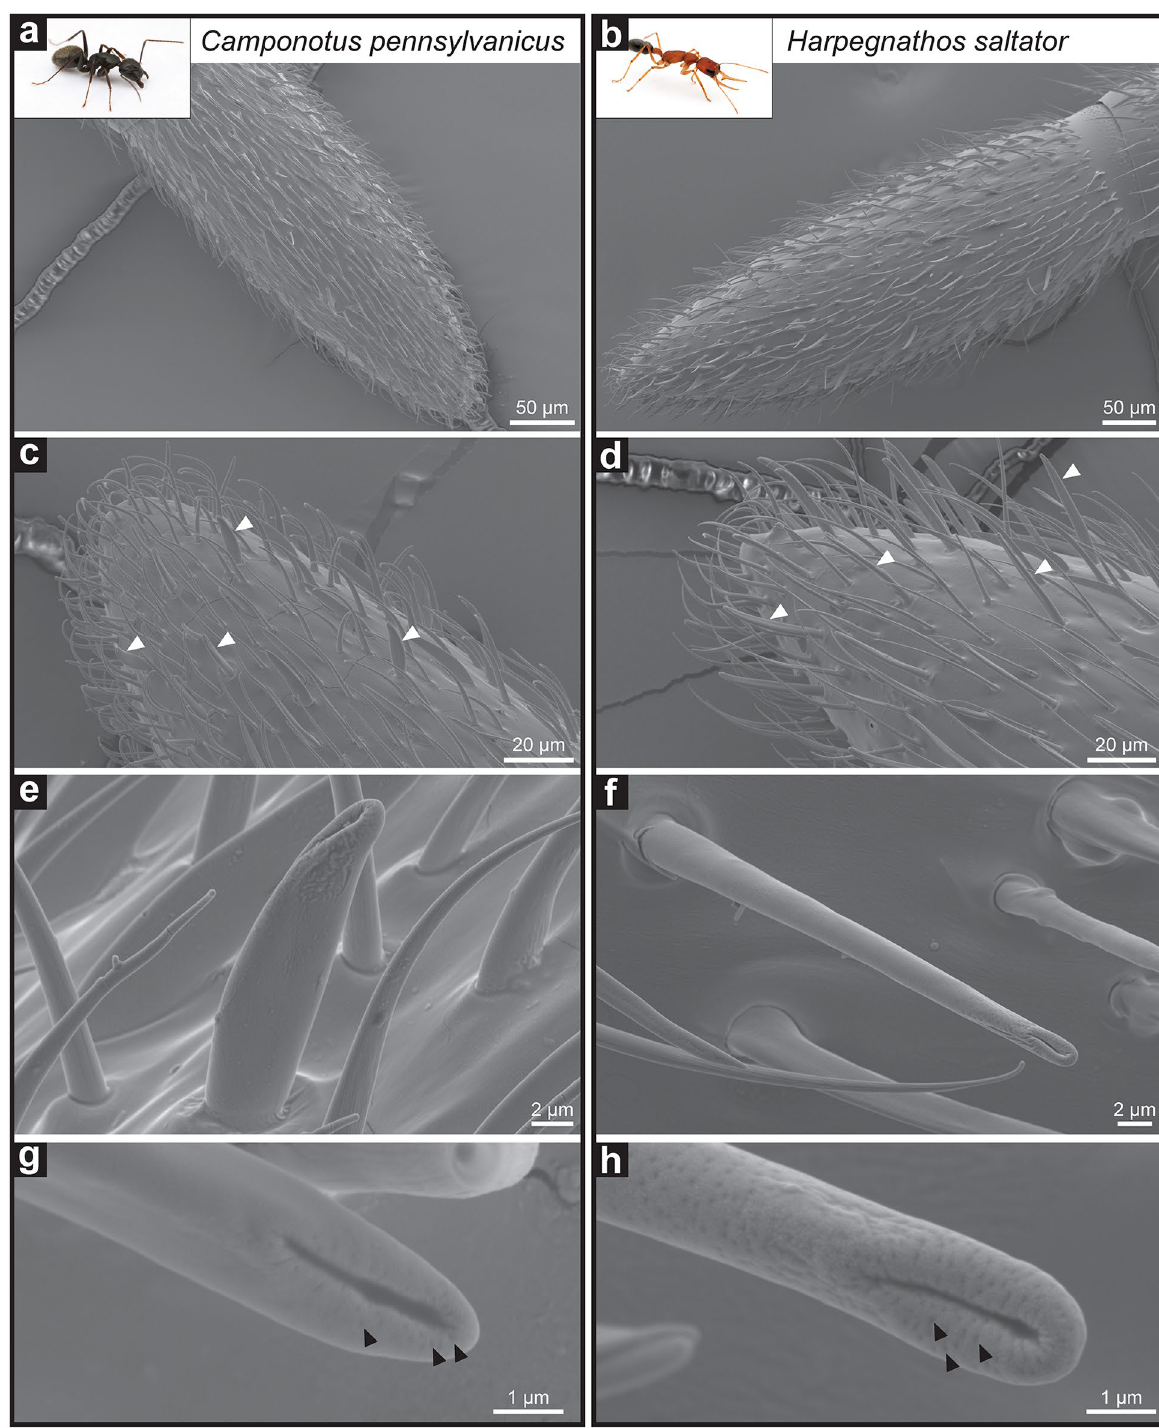
Figure 1. Morphology of chemosensory sensillum in C. pennsylvanicus and H. saltator . Representative images of a Camponotus pennsylvanicus minor worker ( a , c , e , g ) and Harpegnathos saltator worker ( b , d , f , h ). Panels depict the full 10th segment of the funiculus ( a , b ) and its distal tip with some basiconic sensilla highlighted by white arrowheads ( c , d ). Images of a basiconic single sensillum ( e , f ) and the terminal end ( g , h ) depict a large concave depression and several smaller pores indicated by black arrowheads. Inset ant images are provided courtesy of Alex Wild